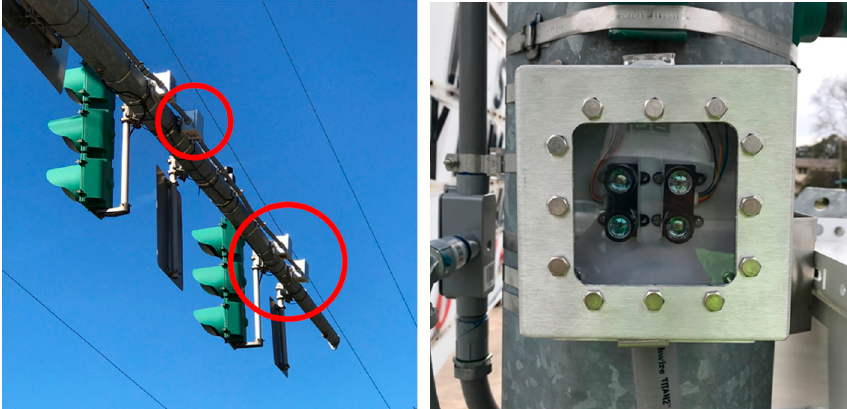
Figure 5. Installation of vertical sensors ( left ) and sample weatherproof enclosure for sensors ( right ) for the proposed